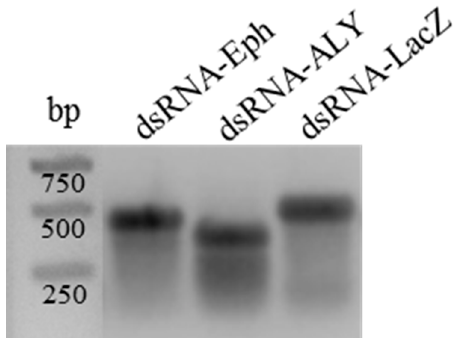
Figure 5. Electrophoretic mobility of in vitro synthesized double-stranded RNA (dsRNA). 800 ng of dsRNA-Eph, -ALY, and -LacZ synthesized in vitro were deposited on a 1% agarose gel stained with ethidium bromide. Sizes (in bp) of the molecular markers are indicated. Due to the double-stranded structure of the RNA, their mobility is reduced.